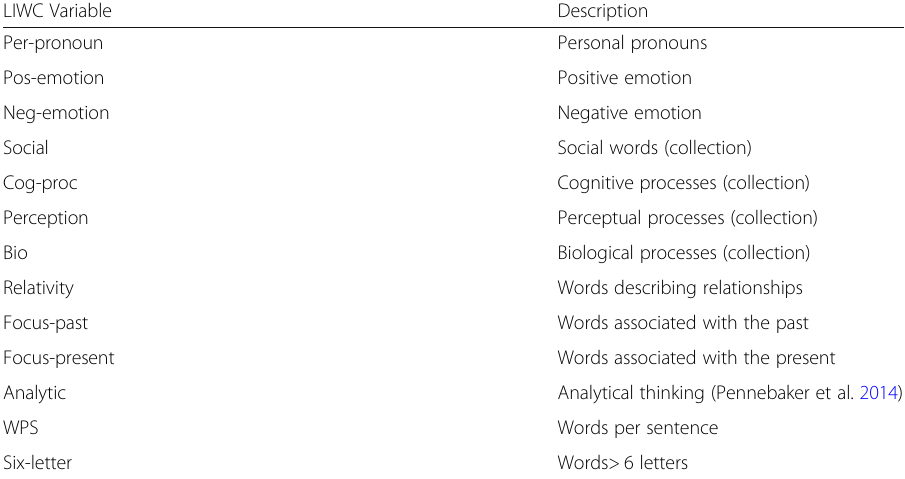
Table 4 LIWC variables for chat log